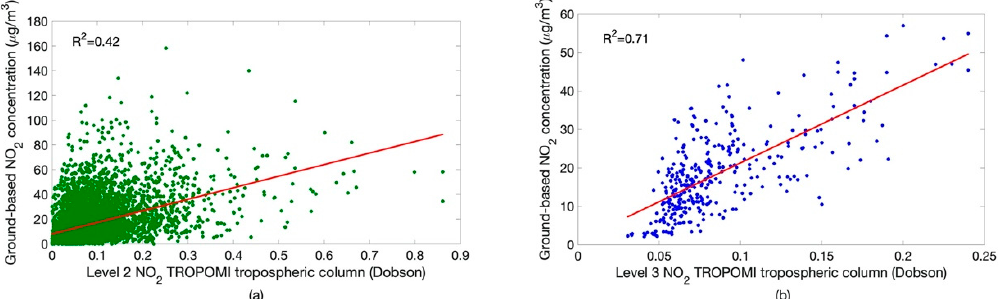
Figure 6. Scatterplot of TROPOMI N2O vs. in situ observations for the 37 validation stations in South Italy (see Figure 2). ( a ) Original data; ( b ) after applying the kriging at 1 km × 1km spatial